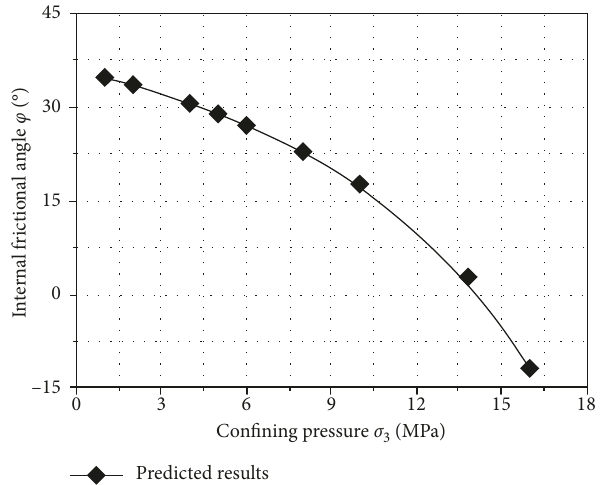
Figure 7: The evolution law of internal frictional angle.